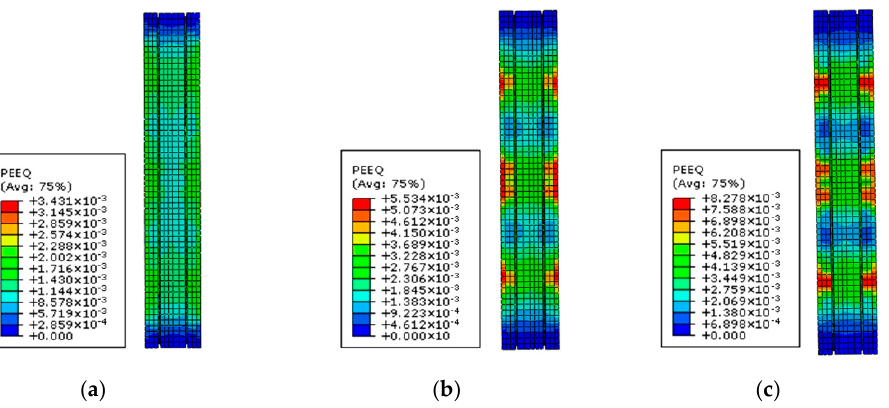
Figure 19. The damage degree to the concrete when the steels with strengths of ( a ) 600 MPa, ( b ) 800 MPa, and ( c ) 1000 MPa yield.